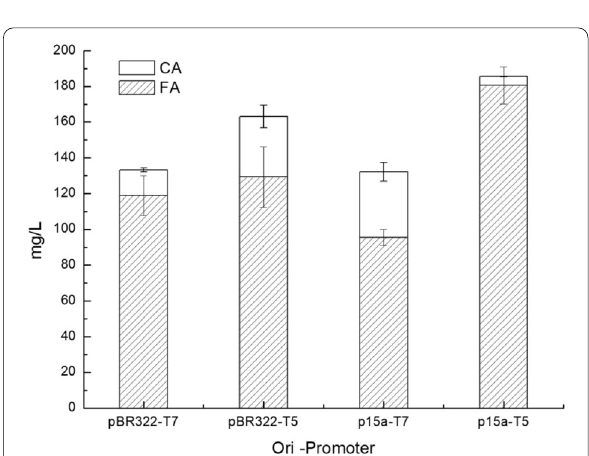
Fig. 3 Effect of combinations of plasmid replicons (pBR322, p15a) and promoter strength (T7 promoter, T5 promoter) on FA production in host cell JM109(DE3). The fermentation was carried out in M9Y medium supplemented with 2% (v/v) glycerol and 1 g/L L -tyrosine at 28 °C and 250 rpm for 5